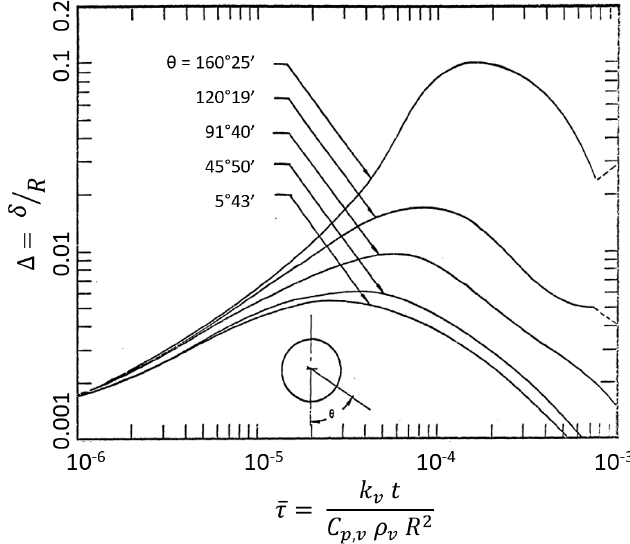
Figure 18. Time dependence (dimensionless time 𝜏̅ on the X-axis) of vapor film thickness ∆ (repre- sented dimensionless on the Y-axis) for different angular locations θ (adapted from Reference [52]).